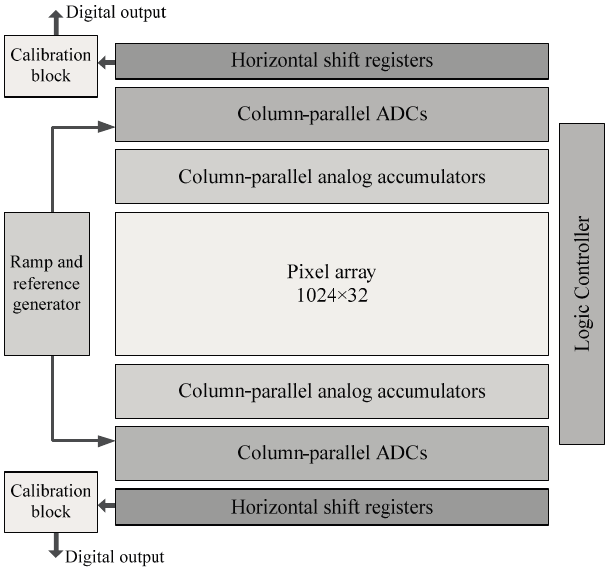
Figure 7. Block diagram of the proposed image sensor.